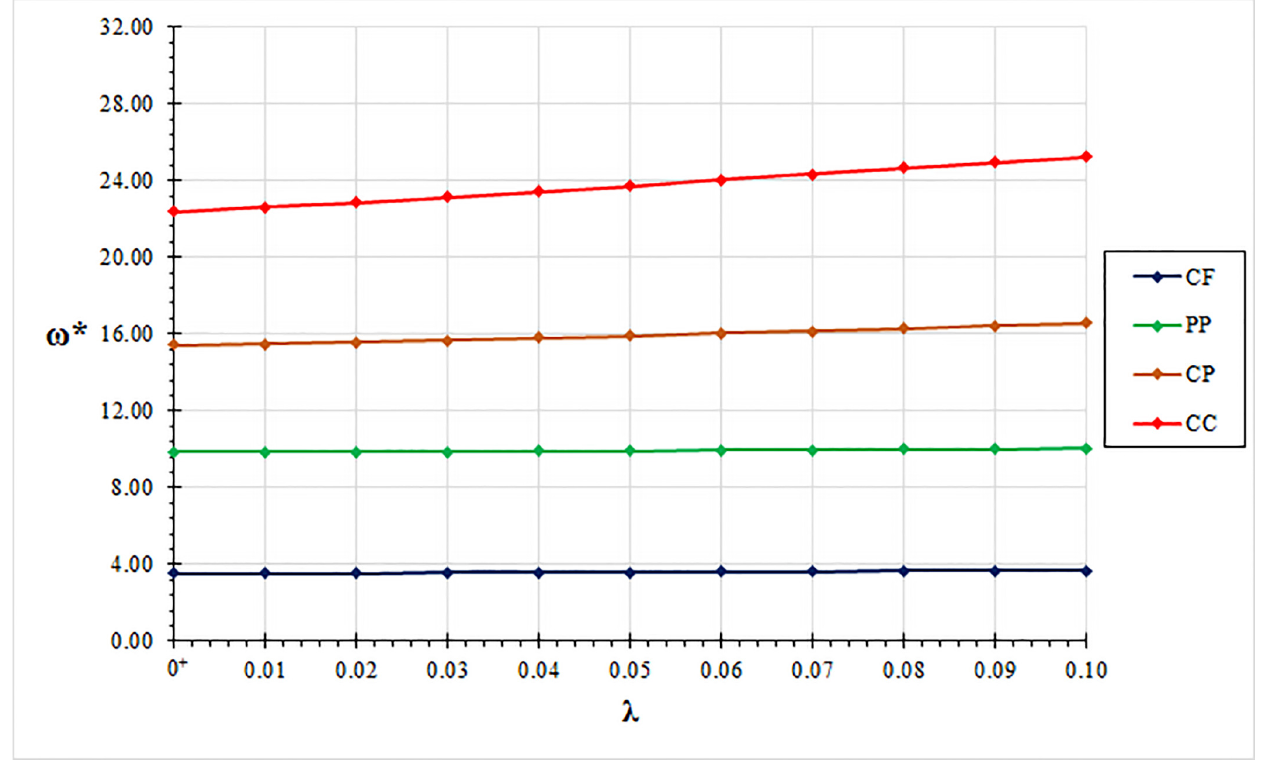
Figure 6. Non-dimensional fundamental natural frequency ω ∗ vs. nonlocal parameter λ , evaluated for mixture parameter α = 0.5, for clamped-free (CP), pinned-pinned (PP), clamped-pinned (CP) and clamped-clamped (CC) structural